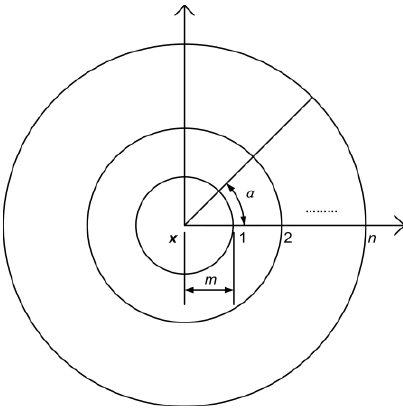
Figure 3. The concentric circles for depth feature extraction.